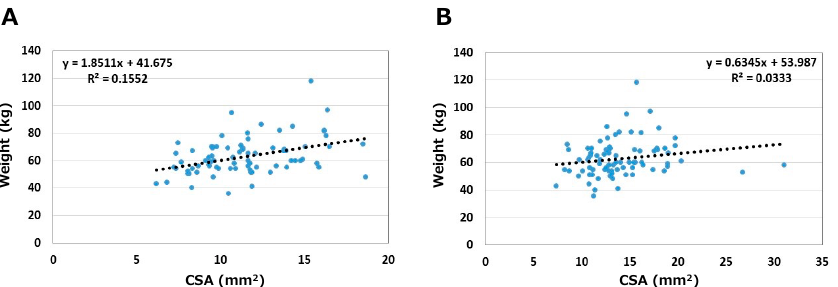
Figure 4. Relationships between weight and CSA. ( A ) Asymptomatic side. ( B ) Symptomatic side. The relationships between BMI and CSA are shown in Figure 5. Correlation coefficients were 0.44 on the asymptomatic side and 0.18 on the symptomatic side. On the asymptomatic side, correlation coefficients between BMI and CSA by sex were 0.40 in males and 0.46 in females. BMI medium correlated with CSA on the asymptomatic side in both sexes ( p < 0.05); slightly stronger in females than in males.